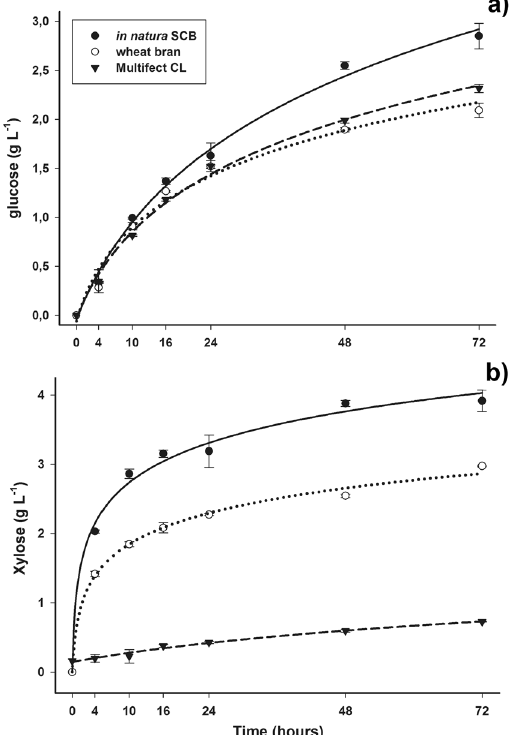
Figure 2. Glucose ( a ) and xylose ( b ) production per time by enzymatic saccharification of alkali pretreated sugarcane bagasse (SCB) using extracts produced by Chrysoporthe cubensis under solid state fermentation (SSF) with in natura SCB ( ● ) or wheat bran ( ○ ) and commercial extract Multifect CL ( ▼